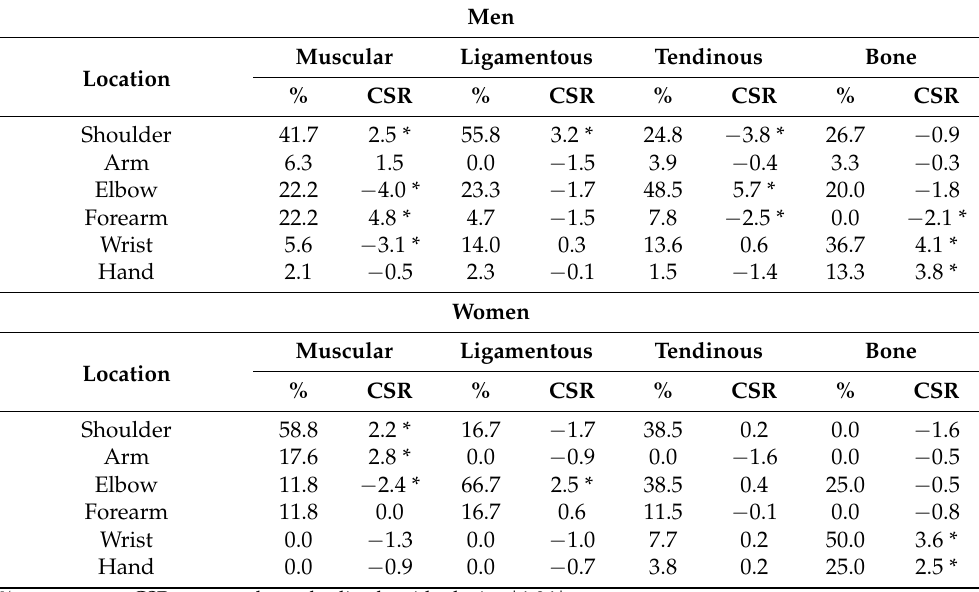
Table 7. Relationship between the type of injury and its location in amateur padel players.